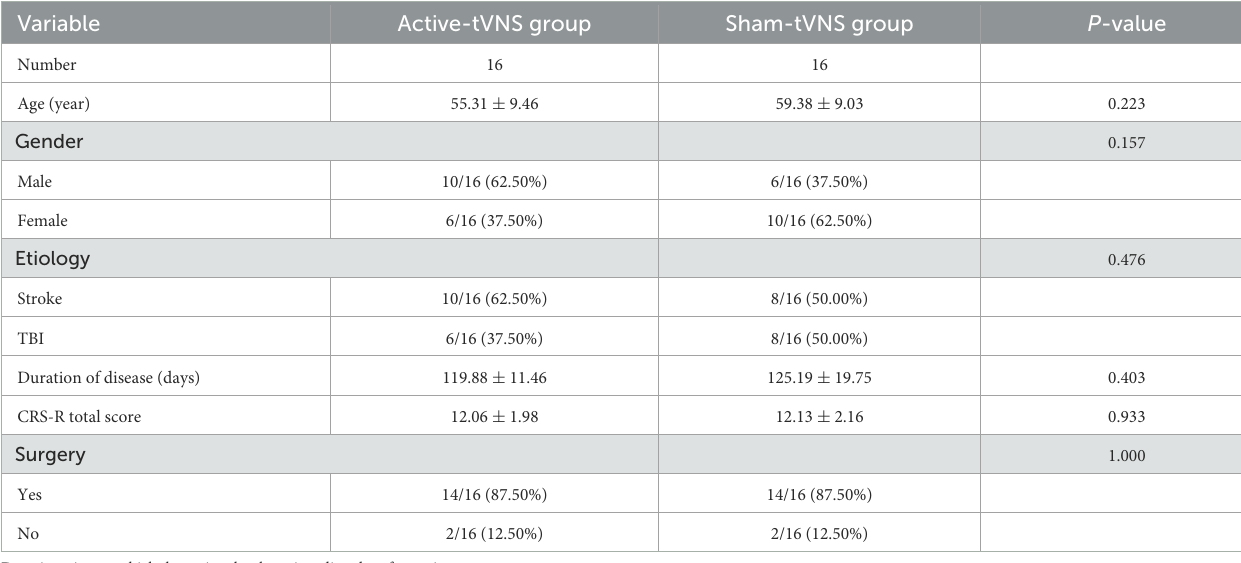
TABLE 3 Baseline demographic and clinical comparisons of MCS subjects undergoing active or sham tVNS.